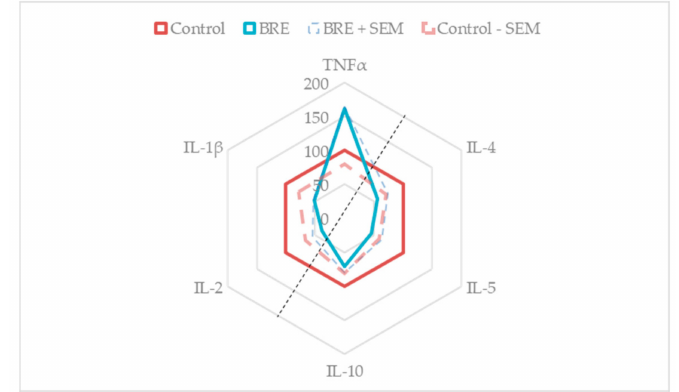
Figure 5. BRE impacted cytokines secretions of PBMCs. Cells were incubated with BRE as indicated and stimulated with PHA (5 µ g / mL) for 24 h. Red solid line: production of main pro- and anti-inflammatory cytokines in Control (PHA-stimulated cells, 0 µ g / mL BRE). Blue solid line: production of main pro- and anti-inflammatory cytokines in supernatants of cells incubated with BRE and PHA. Data were shown as means (Control = 100%). * p < 0.05 compared with Control. Red dotted line: Control mean minus corresponding standard error mean. Blue dotted line: BRE and PHA mean plus corresponding